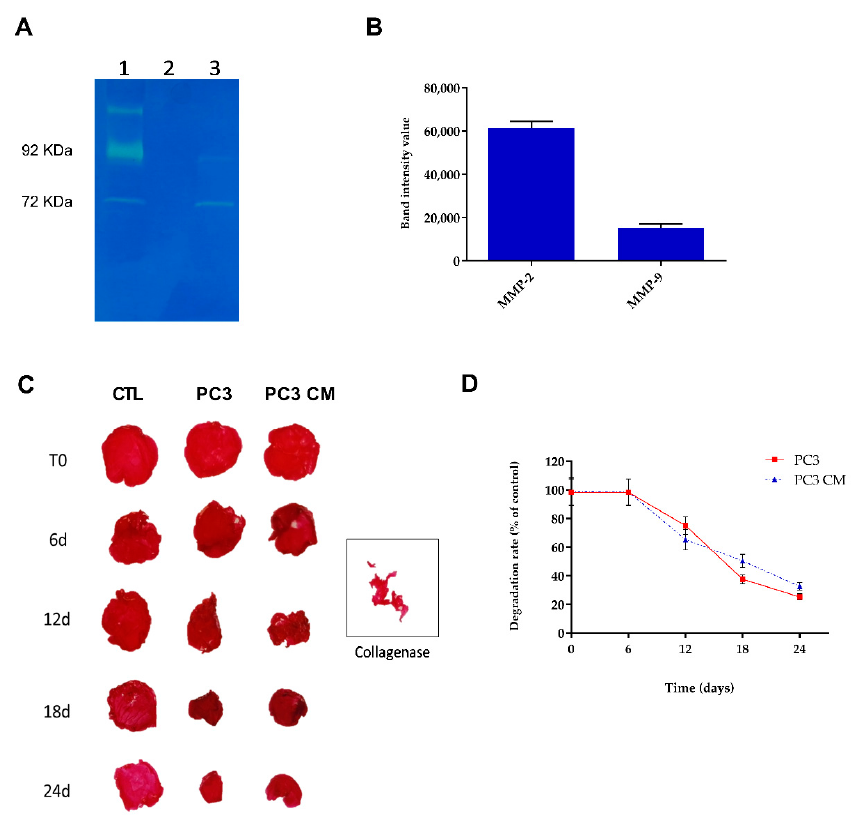
Figure 1. ( A ) Gelatinase zymogram of PC3 cells conditioned medium after 48 h of culture corresponding to the molecular weight of MMP-2 (72 kDa) and MMP-9 (92 kDa). (1-Markers, 2-empty lane, 3-PC3). ( B ) Quantitative densitometric analysis of MMPs expression of PC3 conditioned medium gelatinase zymogram. Data represented as mean ± SEM of three independent experiments. ( C ) Representative photomicrographs of collagen matrices stained with Sirius Red dye after 0, 6, 12, 18, 24 days in presence of PC3’s culture medium (PC3 CM) and in scaffolds containing PC3 cells (PC3). Collagenase was used as positive control. ( D ) Quantitative data of collagen degradation expressed as percent respect to control. Data represented as mean ± SEM of three independent